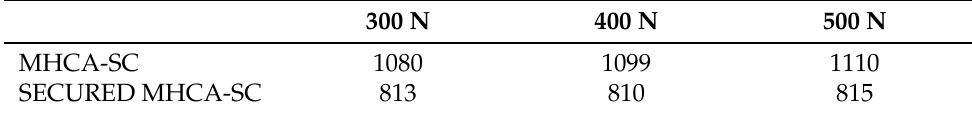
Table 5. Last dead